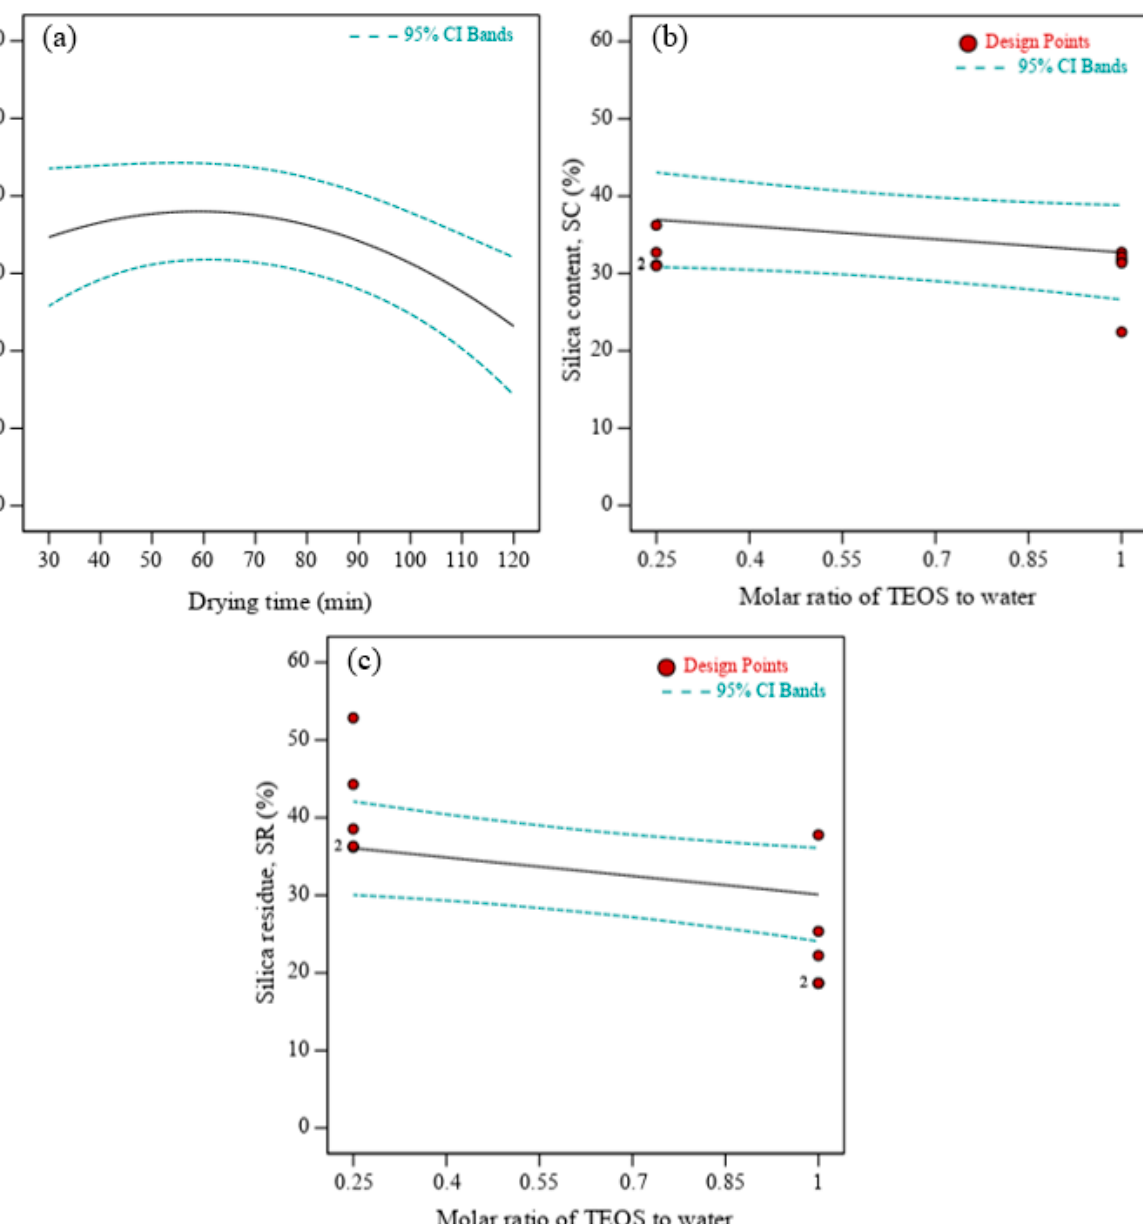
Figure 3. Single-effect of ( a ) drying time and ( b ) molar ratio of tetraethyl orthosilicate (TEOS) on silica content and ( c ) molar ratio of TEOS to water on silica residue.